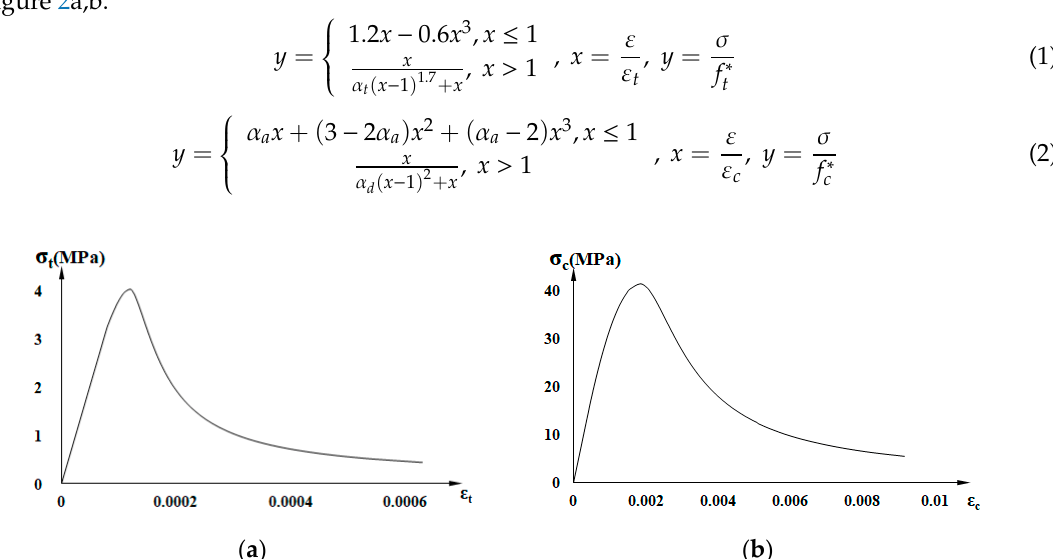
Figure 2. ( a ) The tensile stress-strain relationship of concrete; ( b ) the compressive stress-strain relationship of